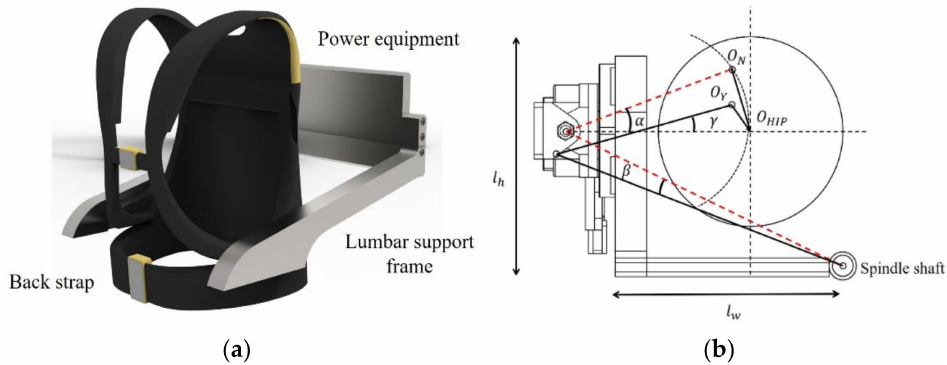
Figure 5. Waist exoskeleton structure: ( a ) Waist exoskeleton structure diagram; ( b ) Plan diagram of the lumbar exoskeleton